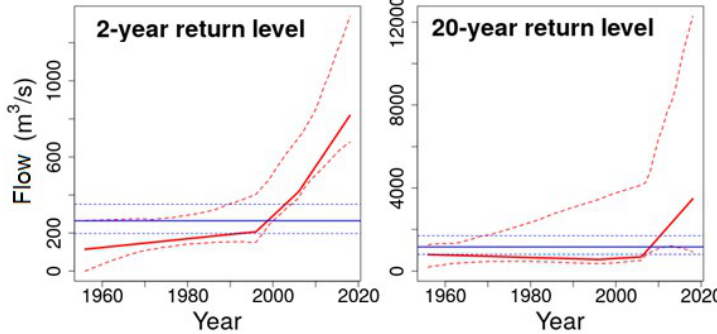
Figure 10. Stationary and non-stationary return time (RT) for the Garbey Kourou flow series for RT 2 (left) and 20 (right) years: in solid line the RT (red = NS, blue = ST), in dotted red the 95% confidence interval (red = NS, blue = ST).